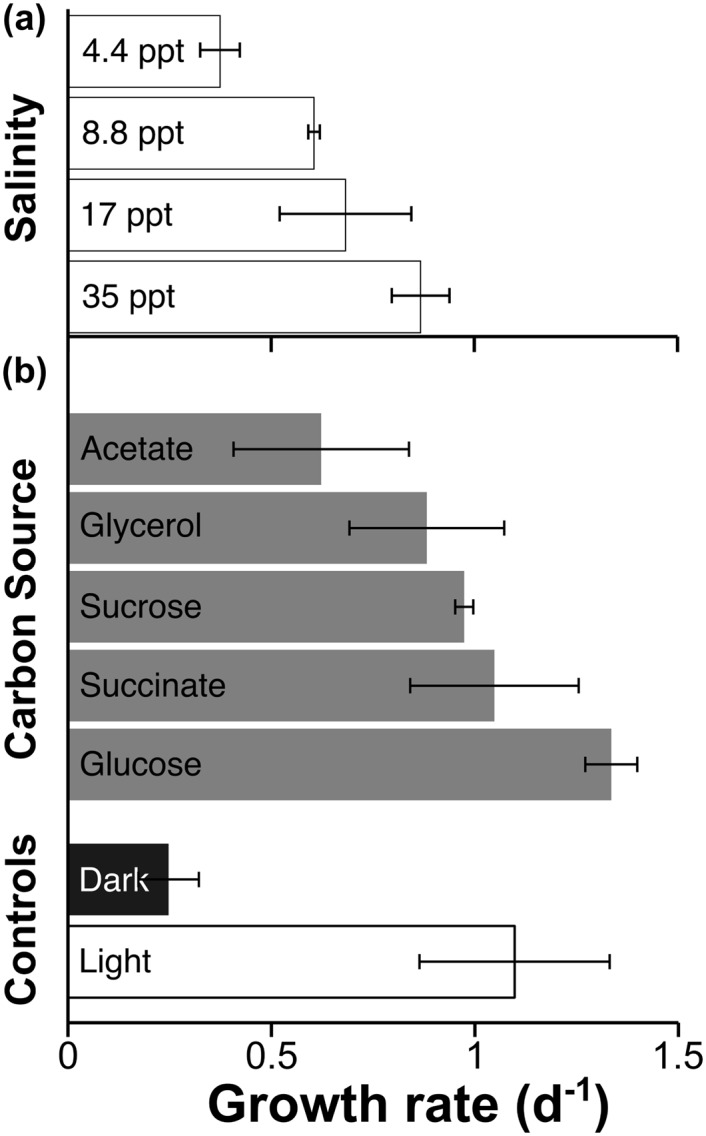
Specific growth rates of Chlorella strain C596.Growth rates (d-1, based on cell density over time) are shown for (a) different salinities and (b) various carbon substrates. White bars indicate photosynthetic growth with a PPFD of 80 μmol photons m−2 s−1; gray bars indicate grown in the dark plus a carbon source at a final concentration of 20 mmol L−1; the black bar indicates growth in the dark. Values are the means of triplicate biological replicates (n = 3); error bars represent ±1 standard error (SE).